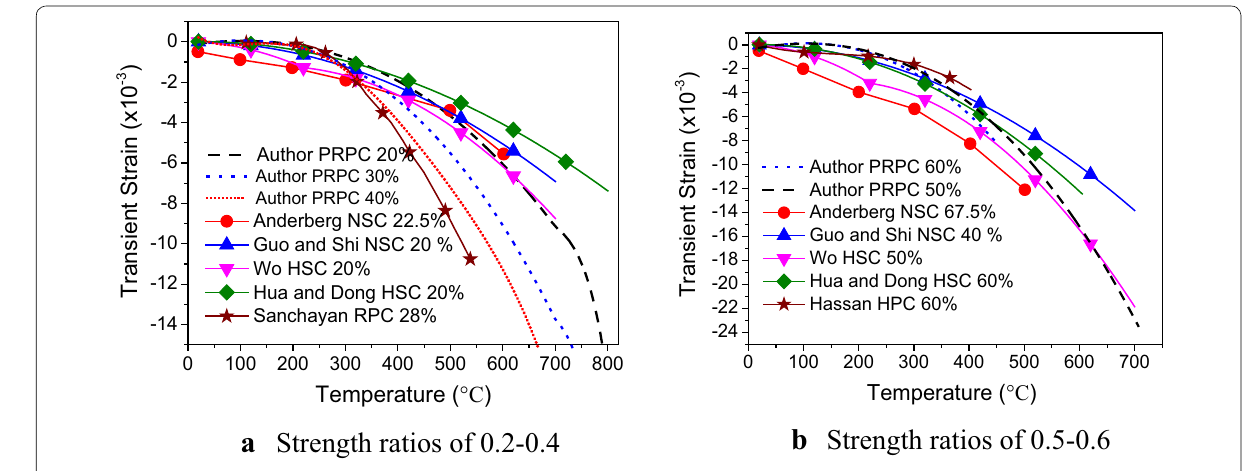
Fig. 18 Comparison of TS of PRPC with NSC, HSC and